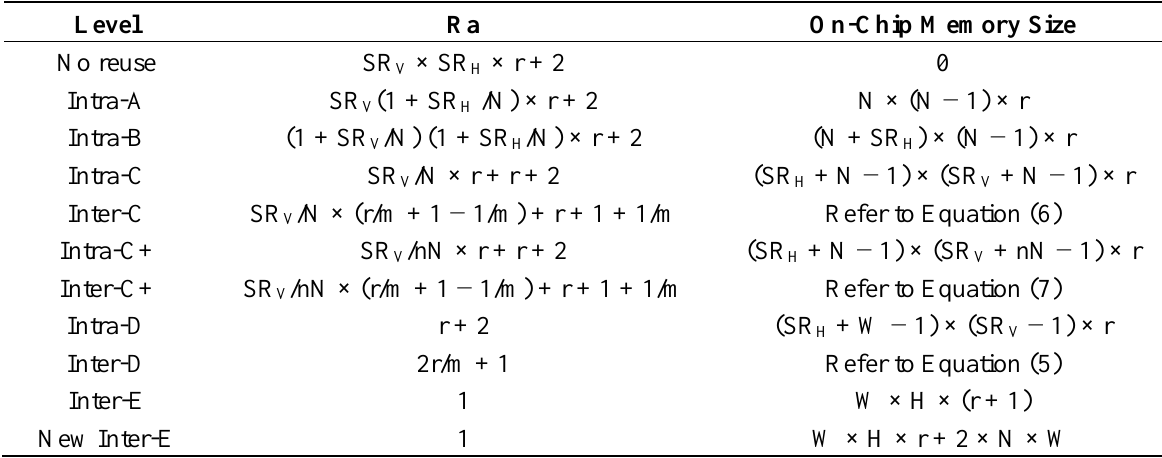
Table 5. Ra and On-chip Memory Size for VC-MRME.